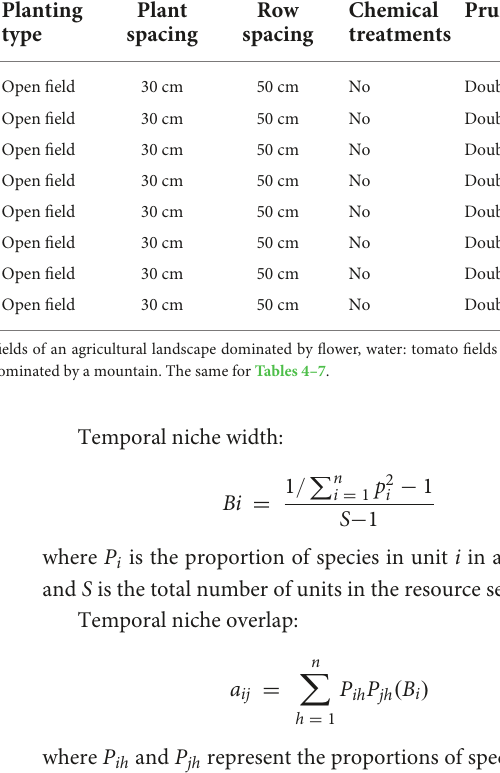
TABLE 1 Agronomic parameters of summer tomato fields in four different agricultural landscapes both in 2018 and 2019. Landscape